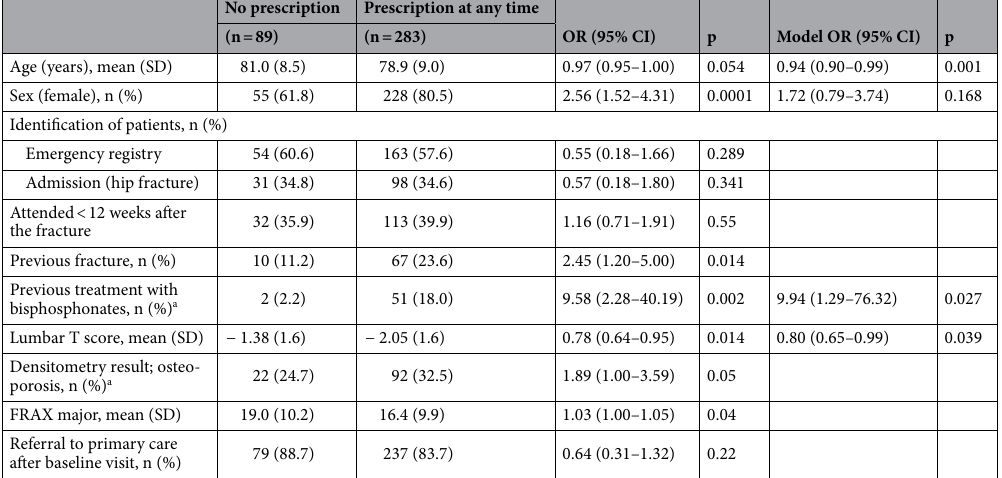
Table 2. Comparison of patients who were prescribed antiosteoporosis medication and those who were not. a Previous treatment recorded in 369 patients. Densitometry values were recorded in 207 patients.